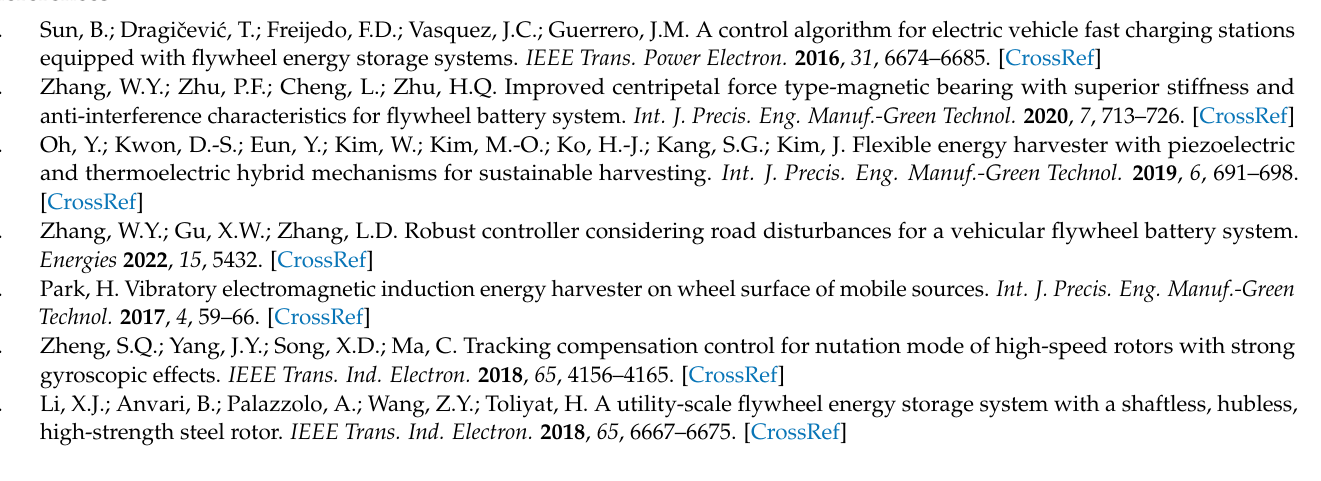
Figure 17. Control current waveforms in turning experiment. ( a ) B-phase control current i B . ( b ) C-phase control current i C .